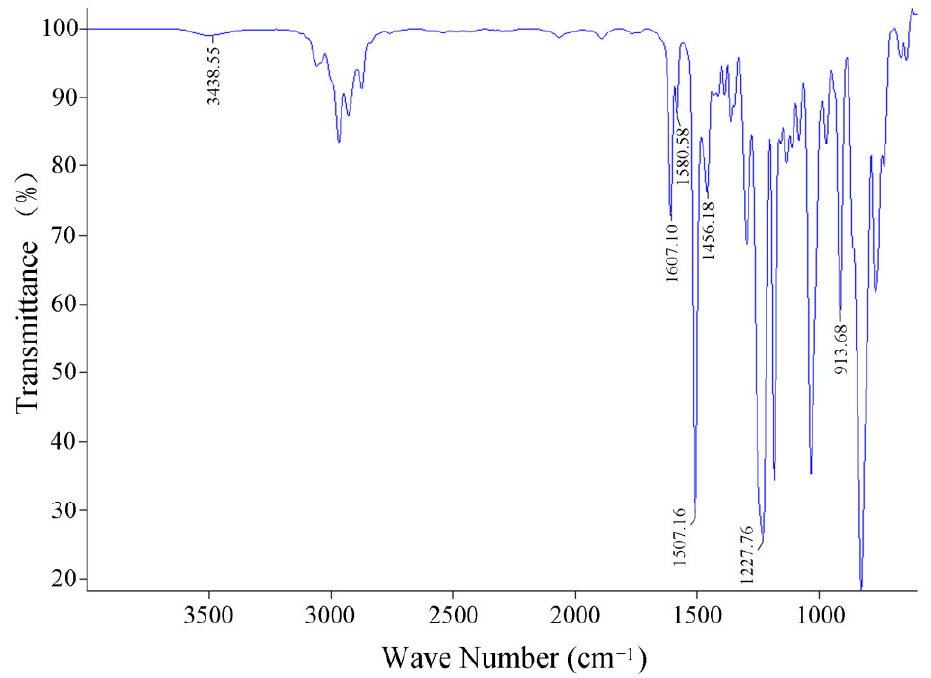
Figure 1. Infrared spectrum of epoxy resin (E51).